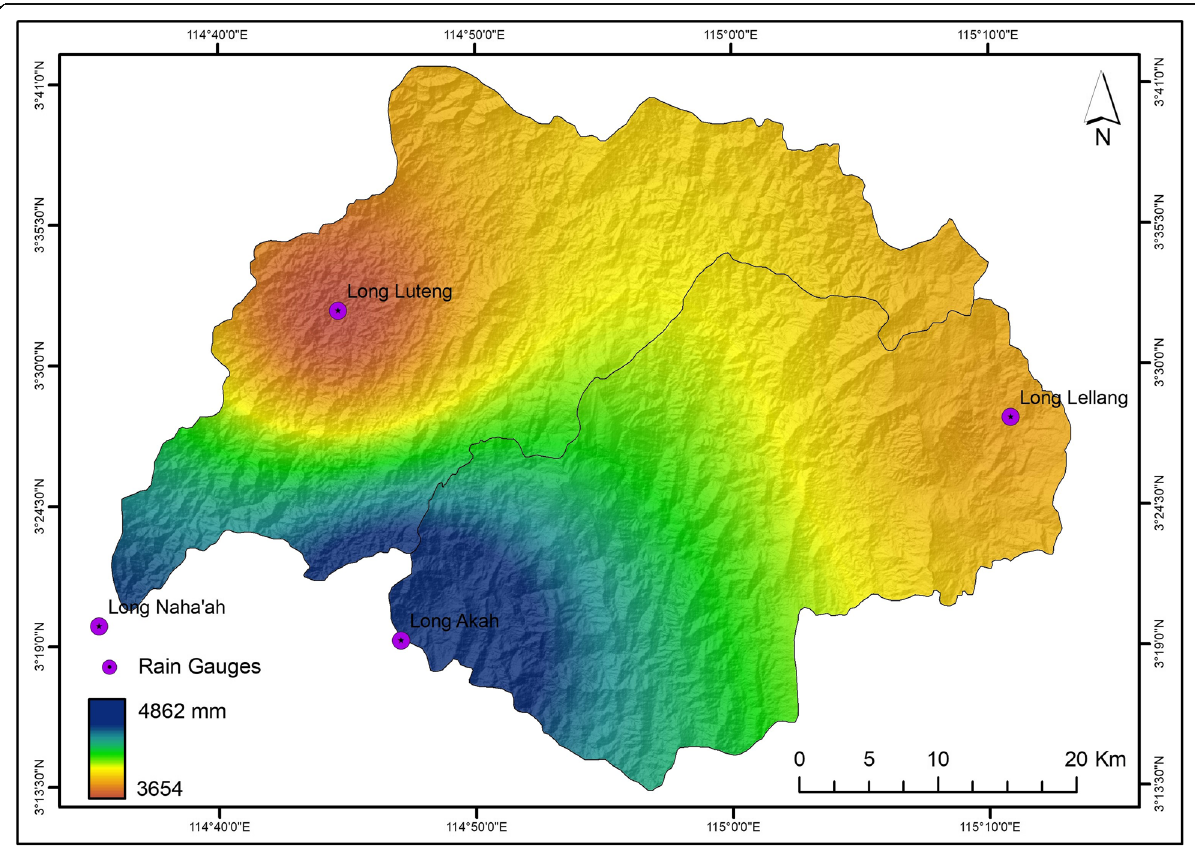
Fig. 7 Spatial distribution of mean annual rainfall in the study